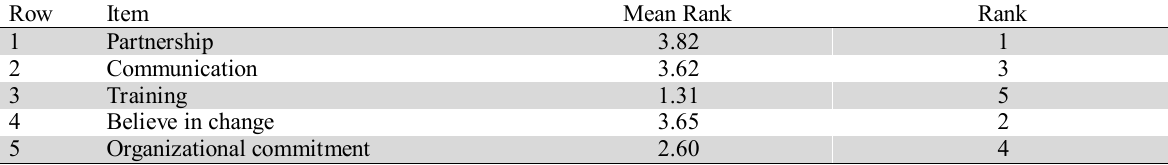
The summary of Freedman test on factors influencing on perceived organizational